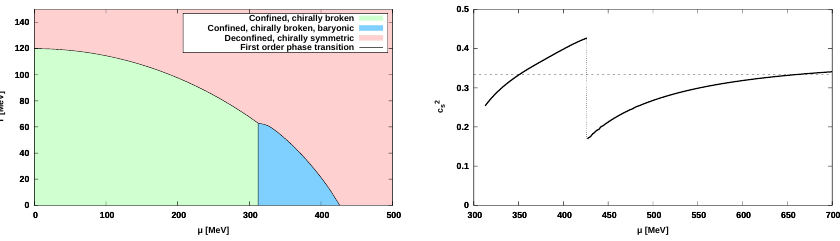
Figure 2. Adding homogeneous nuclear matter in the V-QCD model. Left: The phase diagram on the ( µ, T )-plane. Right: The speed of sound at zero temperature. Figures from